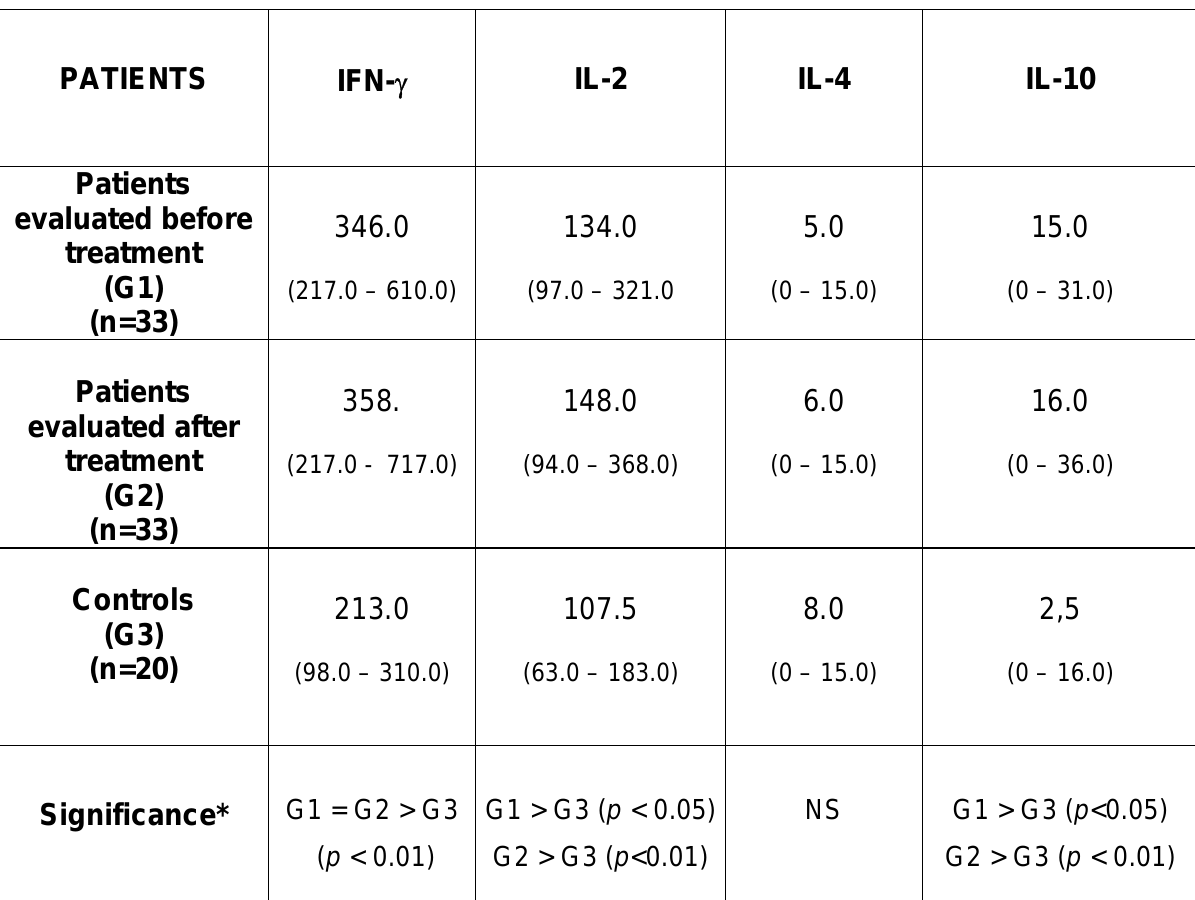
Table 1: Serum levels of Interferon-gamma (IFN- γ ), Interleukin-2 (IL-2), IL-4 and IL- 10 detected in 33 patients evaluated before and after 48 h of treatment with equine immunoglobulin and in 20 healthy